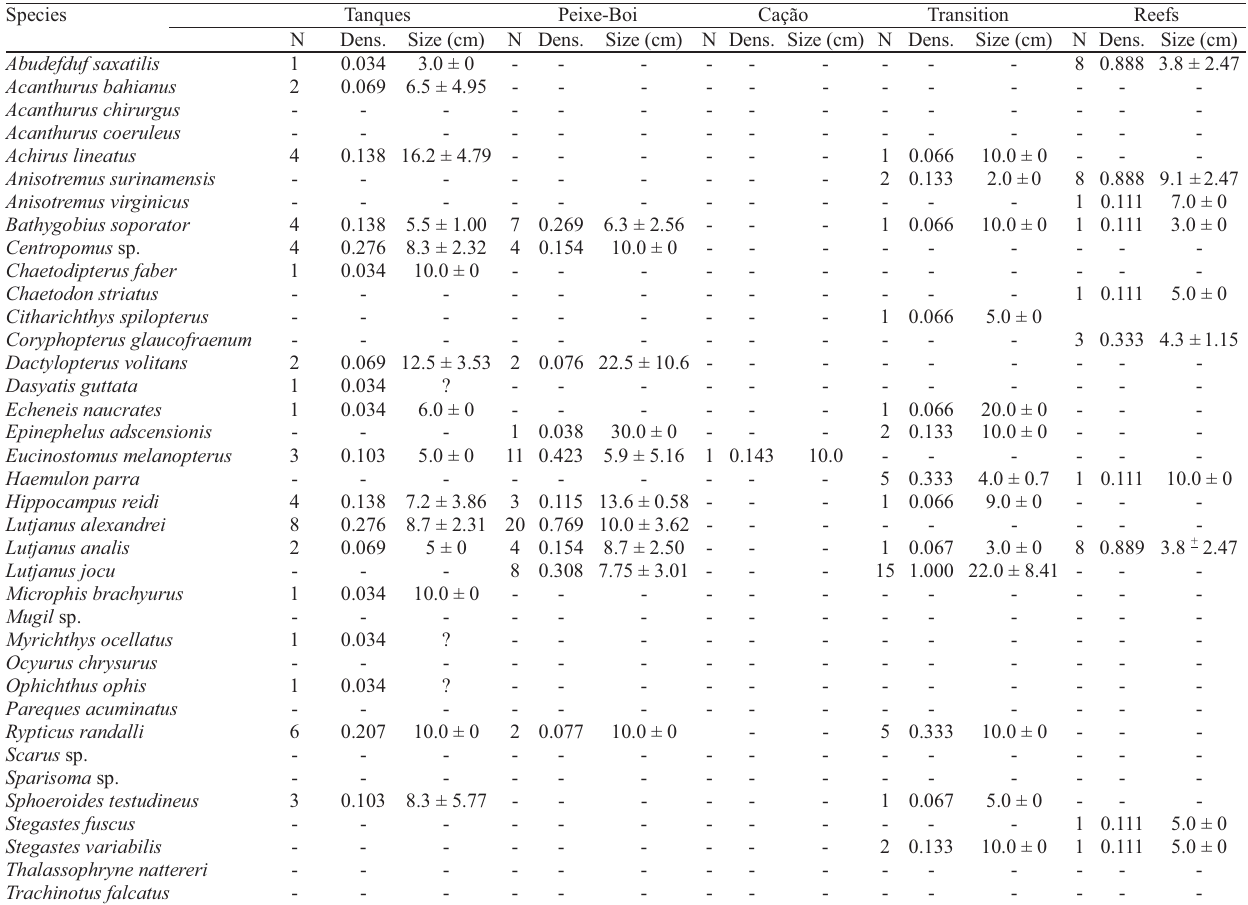
Table 3. Species abundance (N), population density (Dens.) as individuals per 100 m 2 and size (mean + standard deviation) of fishes sighted at the Mamanguape Mangrove-Reef system, State of Paraíba, NE Brazil, according to each sub-area during the dry season (October 2007 to February 2008, and September 2008). ? = undetermined values.